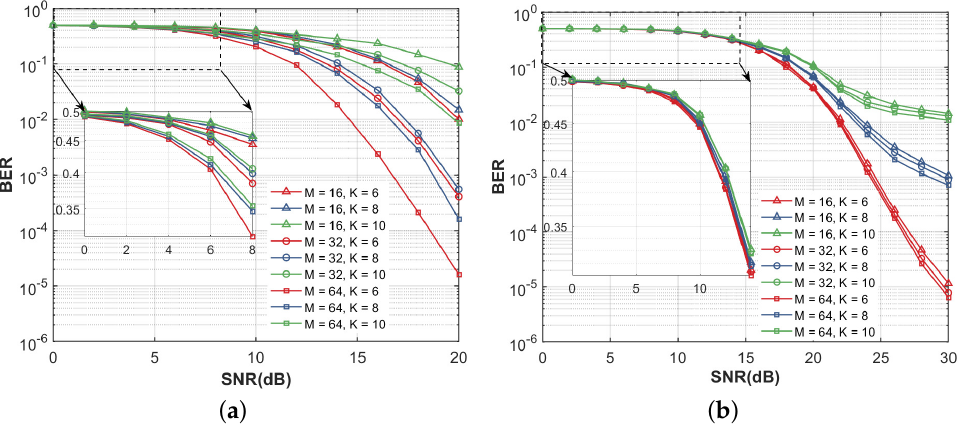
Figure 4. BER performance when the GAMP method is used for demodulation and multiple users are served by 4 RF chains: ( a ) for the proposed analog matrix, ( b ) for the random phase